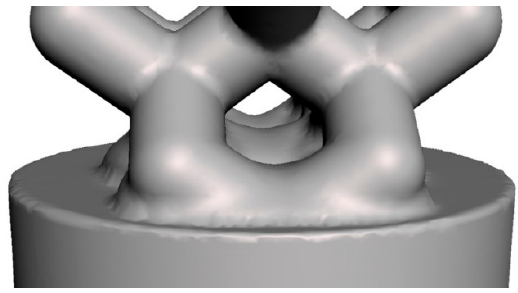
Figure 6. Application of bounded blending operation to assign stiffness to the implant structure.